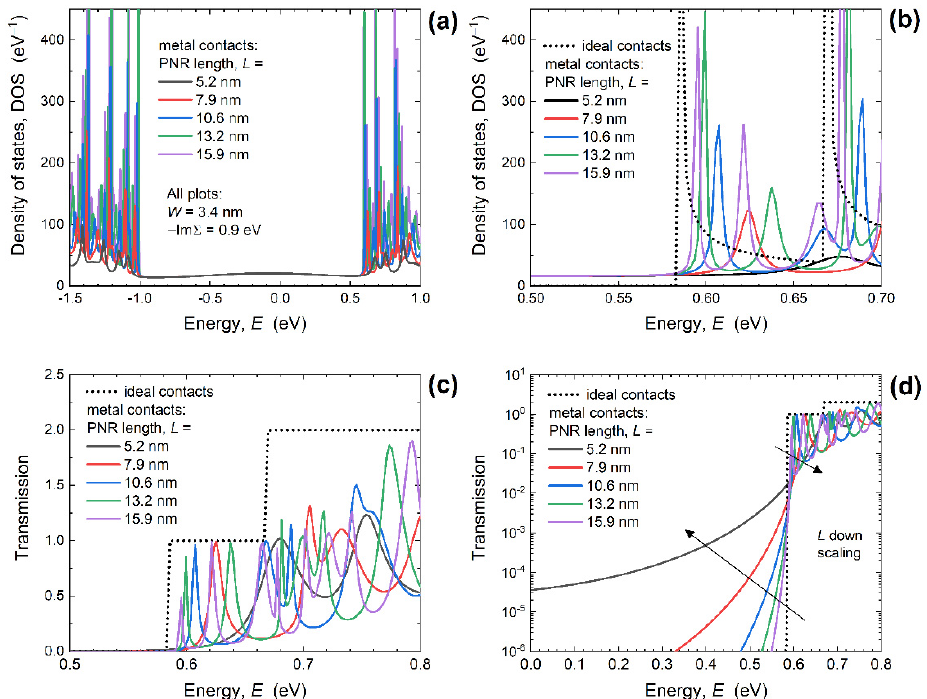
Figure 4. DOS in ( a ) entire energy range, and ( b ) in the conduction band for 3.4 nm-wide PNRs of various lengths with ideal and metal edge contacts. Influence of length downscaling on transmission in the ( c ) linear and ( d ) logarithmic scale. For all MEC-PNRs, − Im Σ R = 0.9 eV.